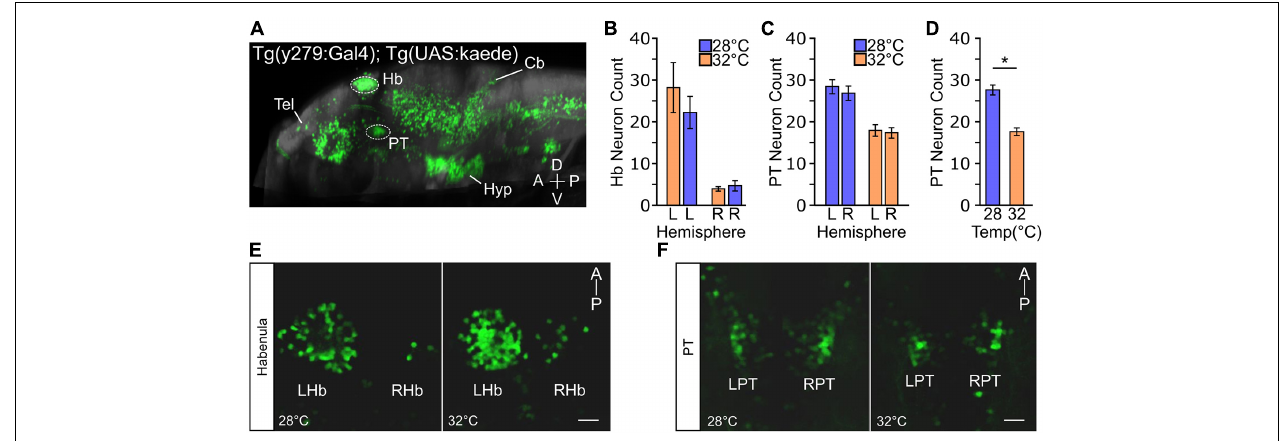
FIGURE 4 | Temperature impacts y279 specified expression in the PT. (A) Single sagittal slice of larval zebrafish brain showing expression of enhancer trap Tg(y279:Gal4) obtained from the ‘Zebrafish Brain Browser’ atlas. Circled regions highlight the habenula (Hb) and rostral posterior tuberculum (PT) and white lines show the telencephalon (Tel), hypothalamus (Hyp), and cerebellum (Cb). (B–F) Effect of elevated temperature during early development on the expression of y279 in the habenula and PT. (B) Expression of y279 in the left and right hemisphere Hb nuclei (28 ◦ C purple, N = 16; 32 ◦ C orange, N = 14). (C) y279 positive PT neurons (28 ◦ C purple, N = 16; 32 ◦ C orange, N = 14). (D) Combined left and right hemisphere PT neuron counts (28 ◦ C purple, N = 16; 32 ◦ C orange, N = 14). (E,F) Representative images showing maximum intensity projections for y279 positive Hb (left habenula, LHb; right habenula, RHb) (E) and PT (left PT, LPT; right PT, RPT) (F) neurons for larvae raised at 28 or 32 ◦ C. Scale bar 20 µ m. Asterisk p <